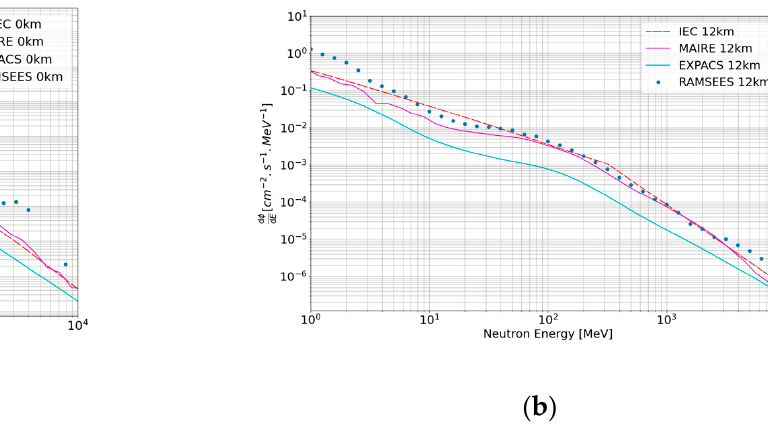
Figure 15. RAMSEES spectrum of secondary neutrons at several altitudes compared to standard and to the models MAIRE & EXPACS: ( a ) ground level compared to JEDEC; ( b ) 12 km of altitude compared to